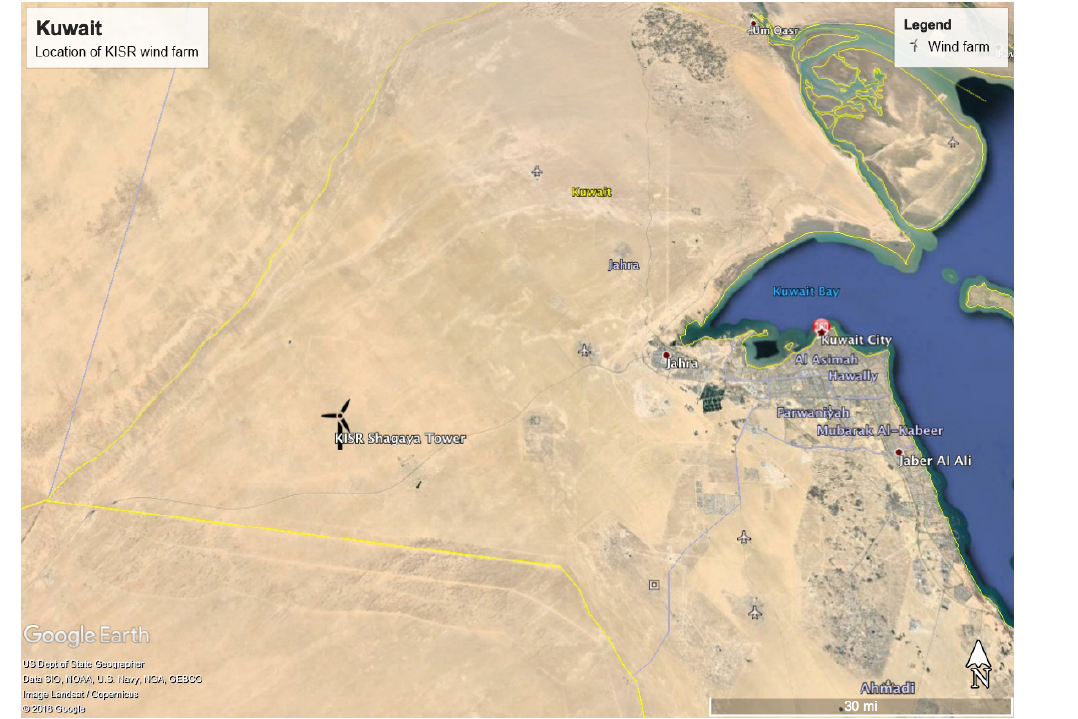
Figure 5. Map of the Shagaya wind farm location in western Kuwait characterized by flat, arid